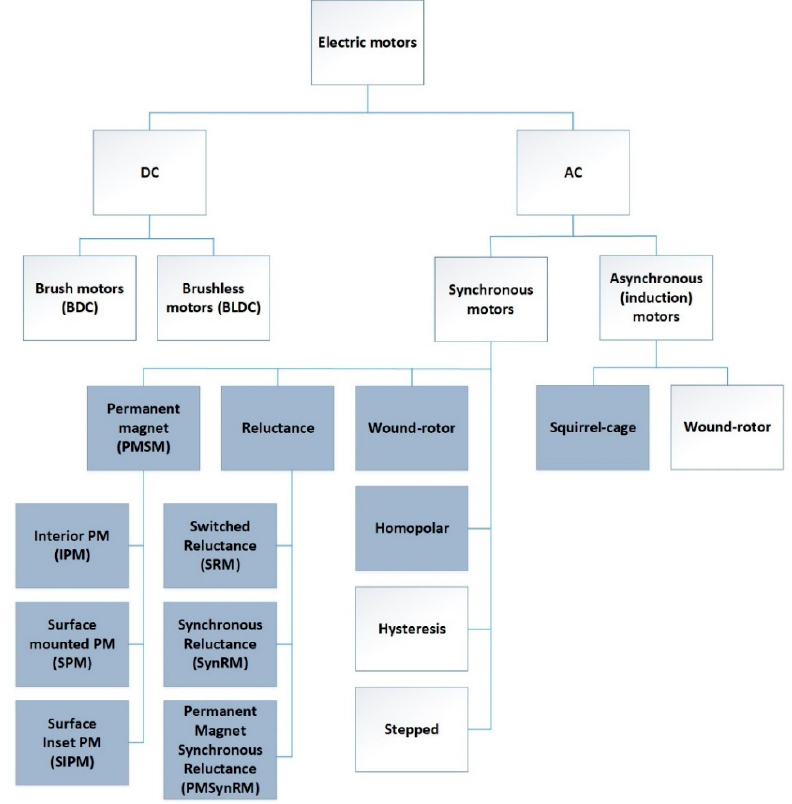
Figure 3. Electrical motors and the selected topologies used in electric vehicles (EVs).